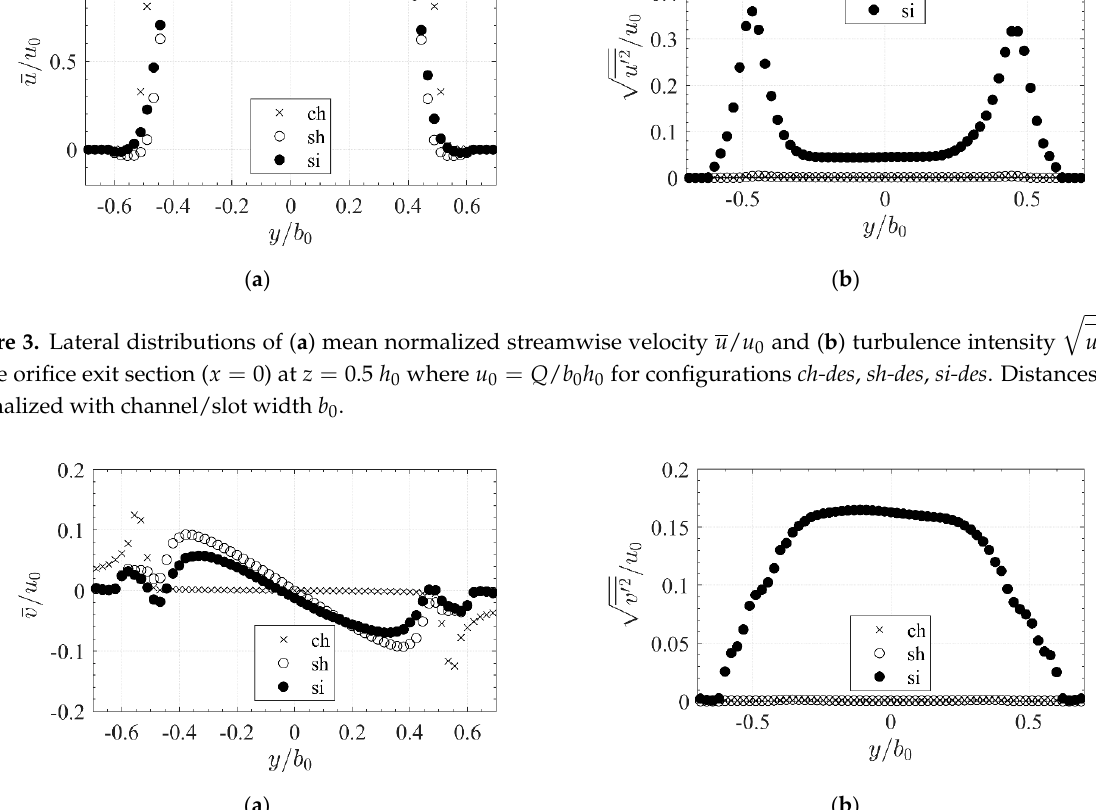
Figure 4. Lateral distributions of ( a ) mean normalized lateral velocity 𝑣̅/𝑢 (cid:2868) and ( b ) turbulence intensity (cid:3493)𝑣 (cid:4593)(cid:2870) (cid:3364)(cid:3364)(cid:3364)(cid:3364)/𝑢 (cid:2868) in the orifice exit section ( 𝑥 = 0 ) at 𝑧 = 0.5 ℎ (cid:2868) where 𝑢 (cid:2868) = 𝑄/𝑏 (cid:2868) ℎ (cid:2868) for configurations ch-des, sh-des , si-des . Distances 𝑦 are nor- malized with channel/slot width 𝑏 (cid:2868) .